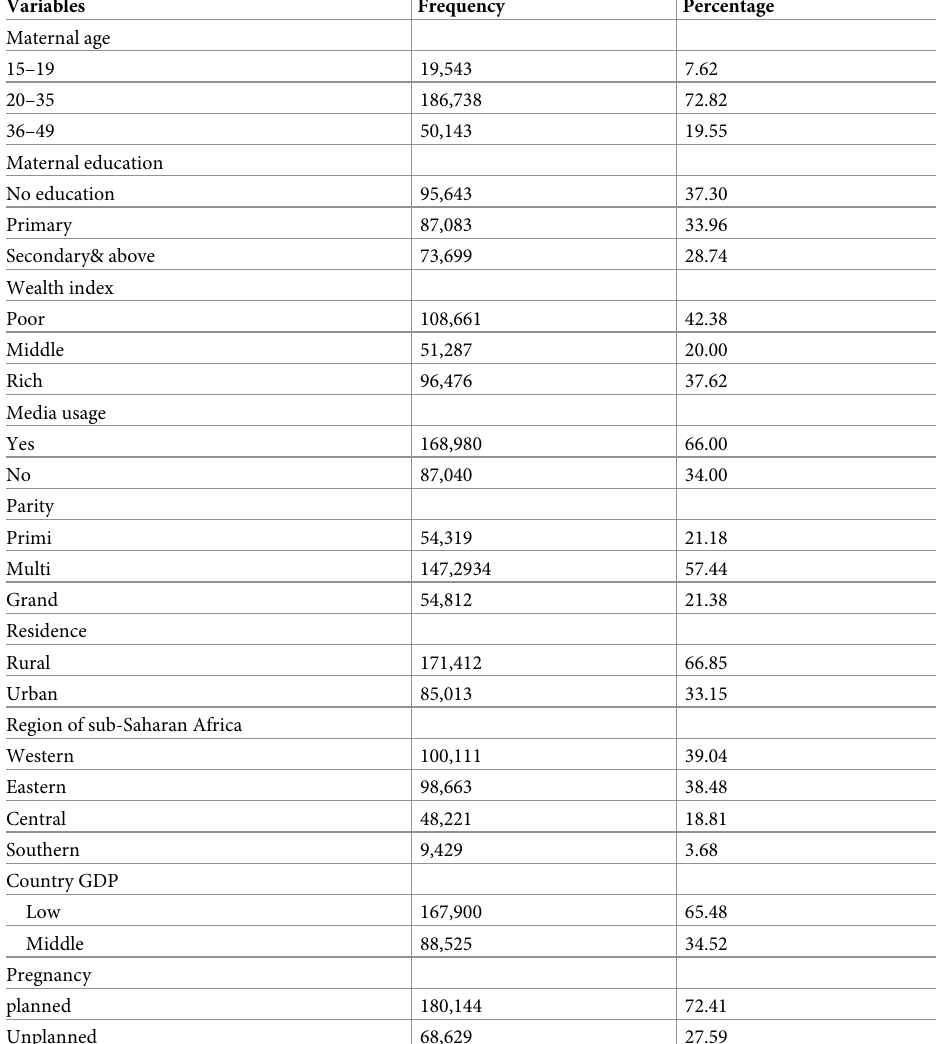
Table 1. Weighted socio-demographic and economic characteristics of respondents DHS 2008–2019 (N =